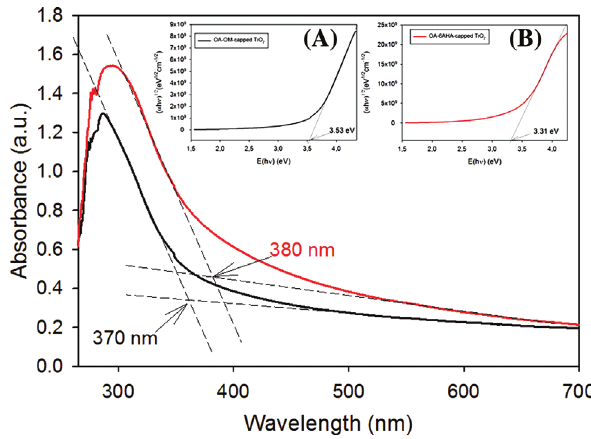
nanoparticles (A) 2 . The insets show 2